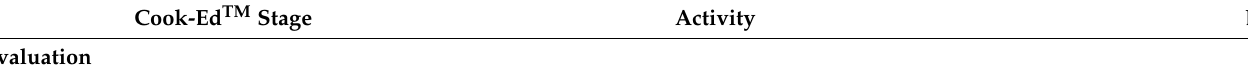
Cook-Ed TM Stage